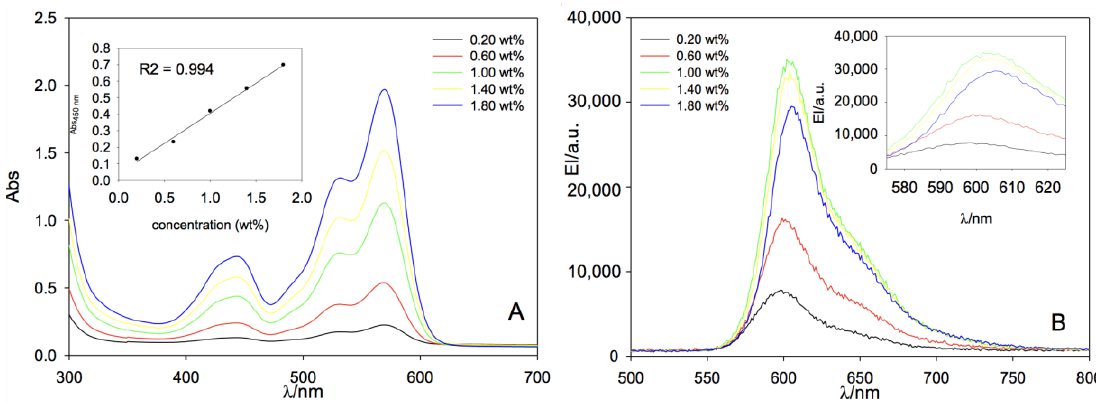
Figure 5. ( A ) UV–VIS absorption. In the inset, the absorbance maximum at 450 nm as a function of LR concentration and ( B ) fluorescence emission spectra PCHMA films at increasing dye concentration. λ exc = 450 nm and film thickness of 23 ± 6 µ